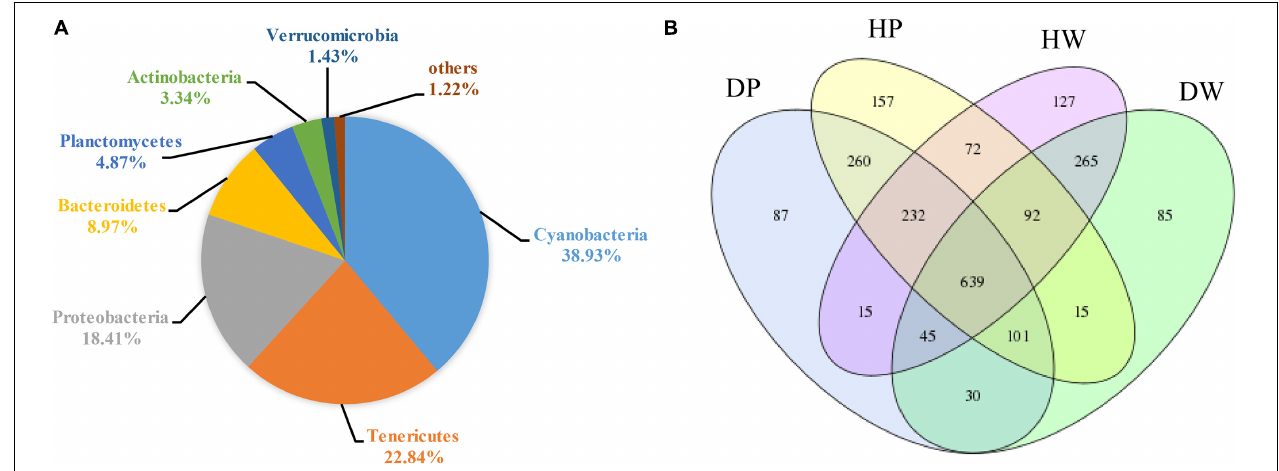
FIGURE 1 | (A) Bacterial community in all samples at the phylum level. Less than 1% abundance of the phyla was merged into others. (B) Comparison of OTUs in DP, DW, HP, and HW by Venn